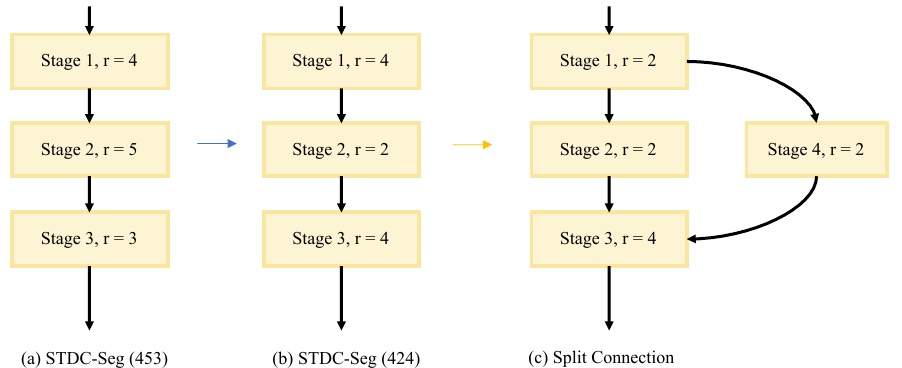
Figure 6. ( a ) Original STDC-Seg backbone, ( b ) backbone with simplified network depth, ( c ) split connection backbone. r denotes STDC block repeat